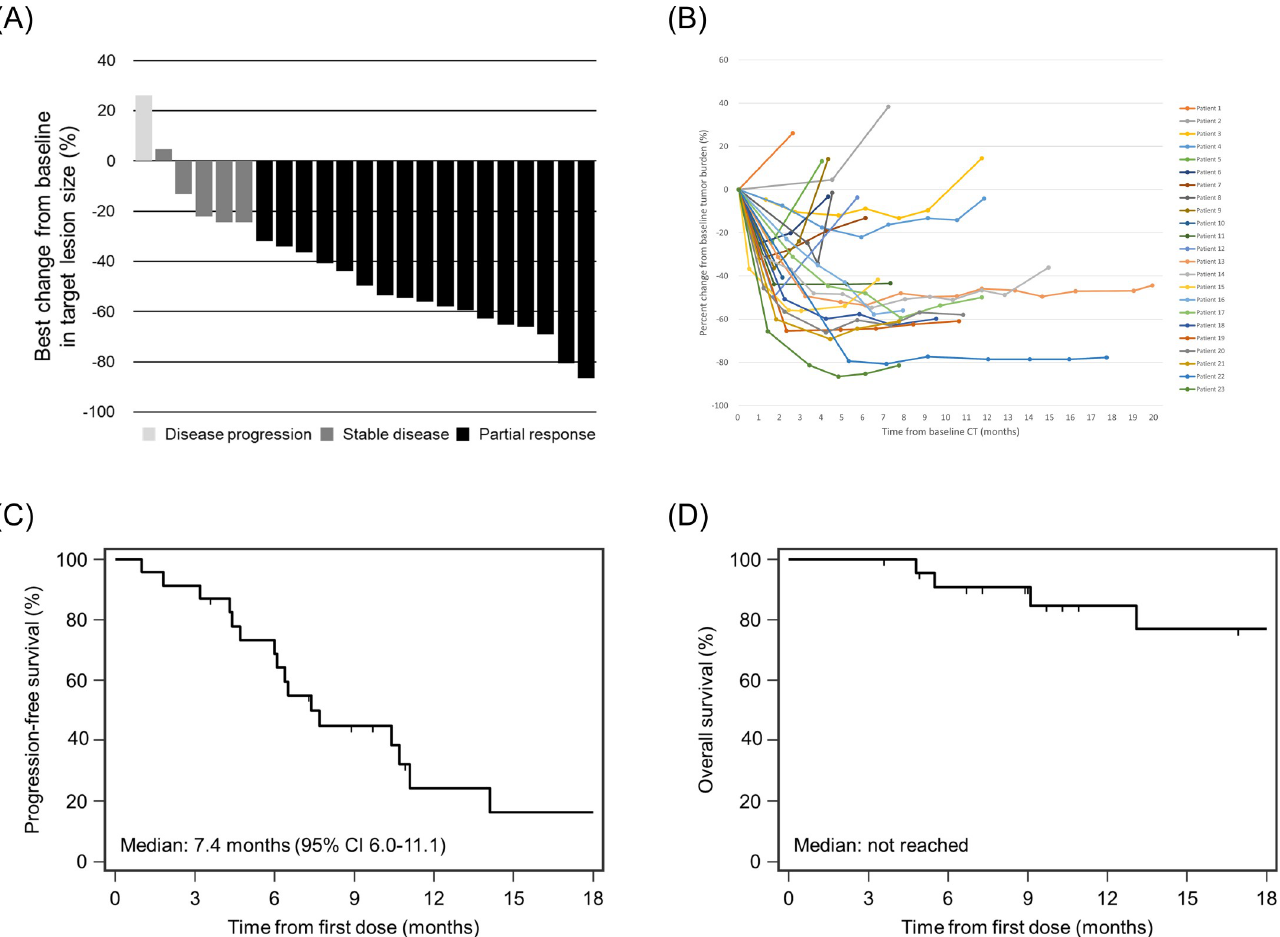
Fig 2. Response to osimertinib by RECIST 1.1 in real-world practice. (A) Waterfall plot of best percentage changes in target lesion size. (B) Spider web graph showing the percent change from baseline in the tumor burden. (C) Kaplan-Meier analysis of progression-free survival. (D) Kaplan-Meier analysis of overall survival. Abbreviations: CI, confidence interval; CT, computed tomography.